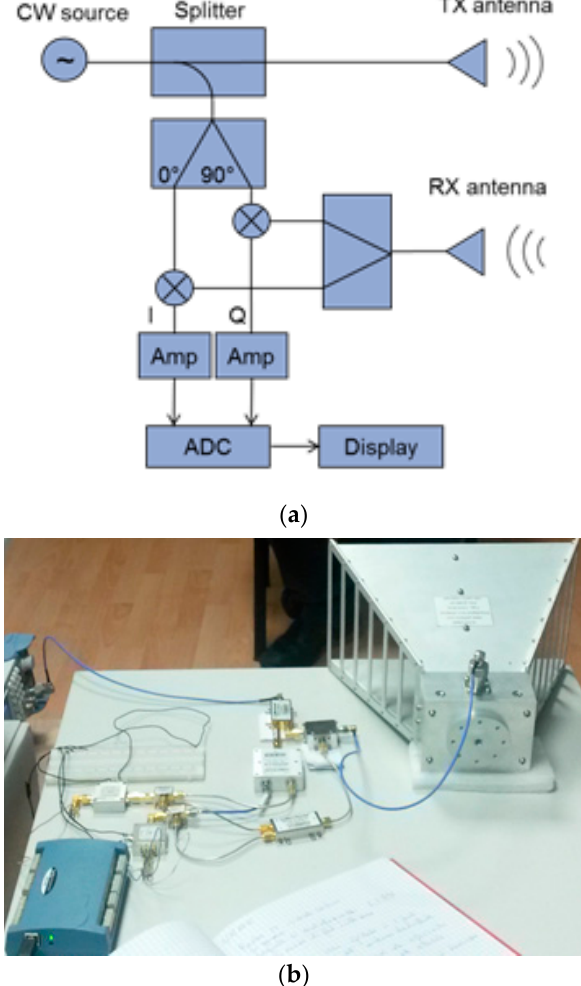
Figure 1. Bioradar system. ( a ) The block diagram of the radar architecture; ( b ) Photo of the bioradar prototype.